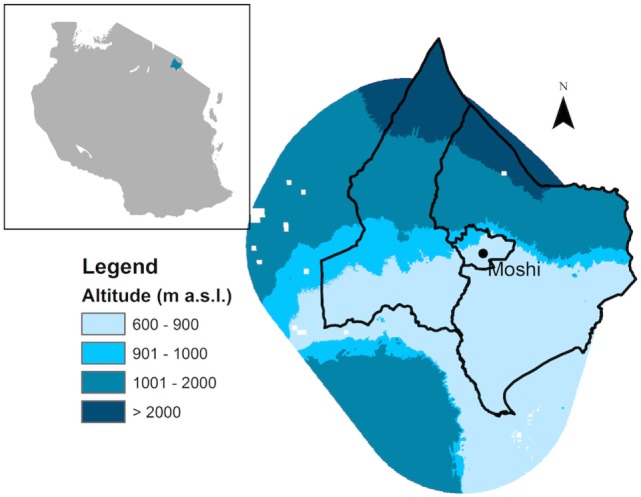
Map of study area in the Hai and Moshi districts of Tanzania showing elevation zones.